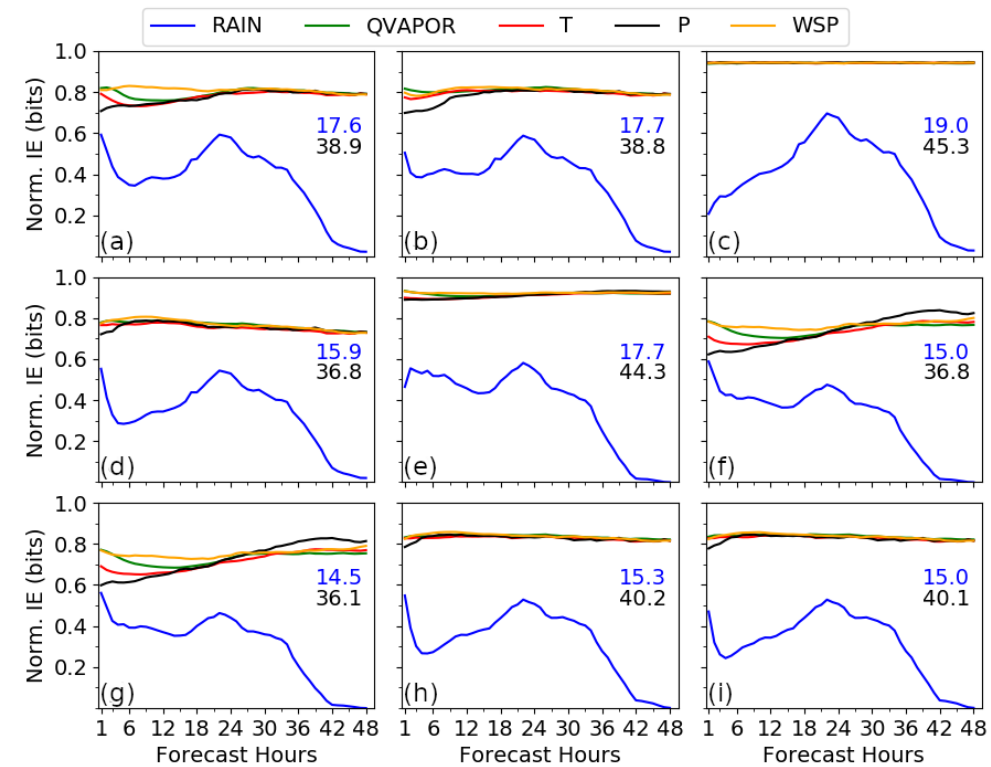
Figure 8. Temporal evolution of the information entropy computed for rain, temperature, water vapor, pressure, and wind speed for the nine experiments set in Table 4. The experiments appear ordered from ( a – i ), respectively. Valid for the simulation period starting at 00Z on 27 February